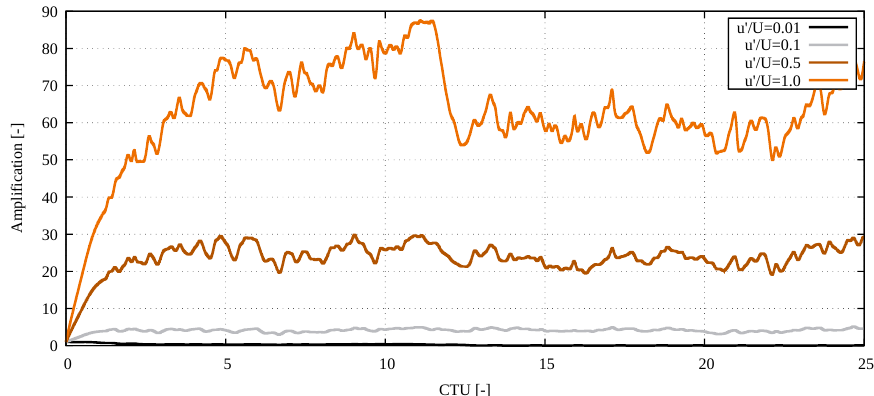
Figure 8. Amplification factor from the controller for different turbulence intensities.